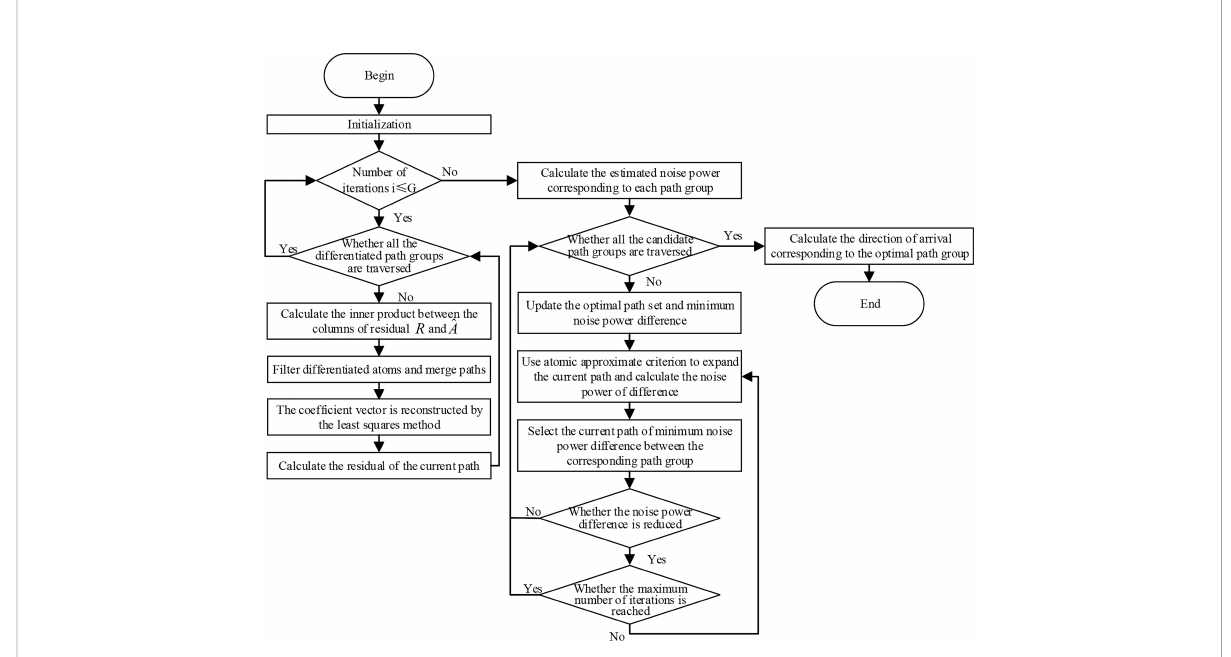
FIGURE 5 The fl owchart of the DCMP reconstruction